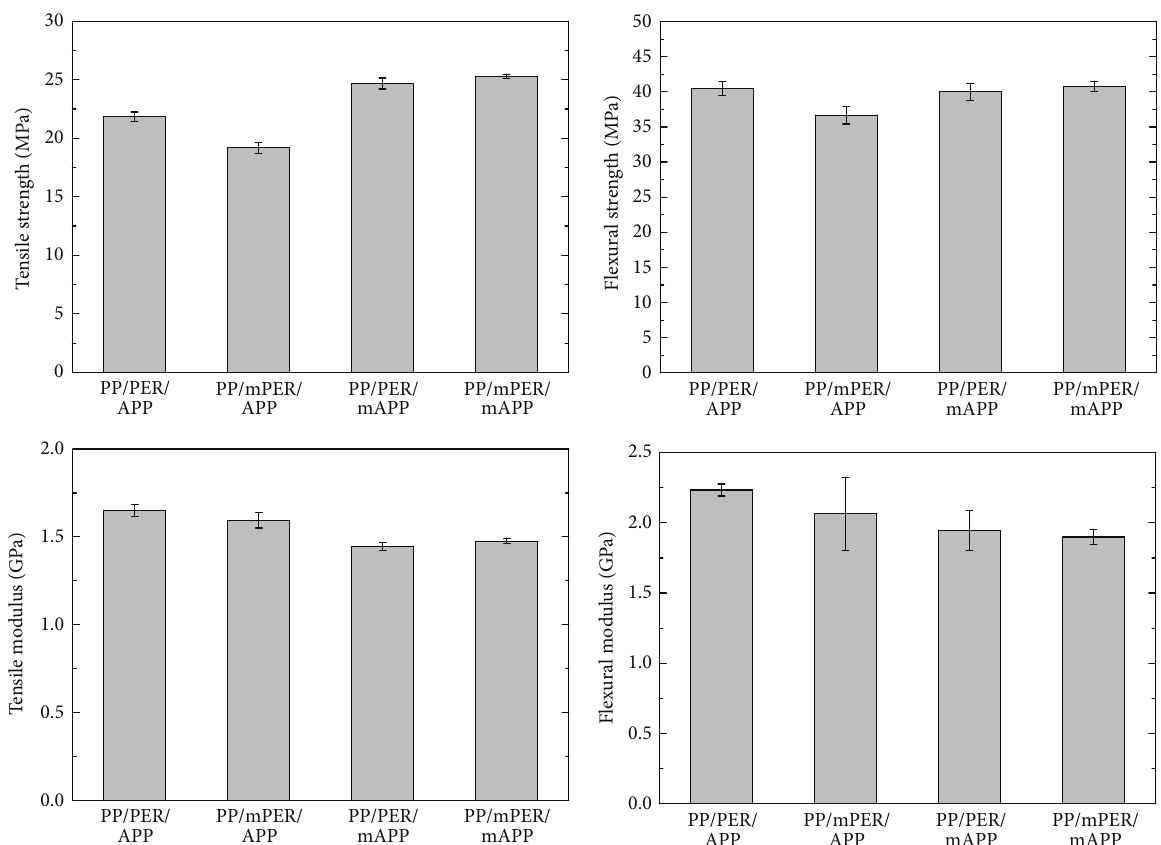
Figure 6: Comparison of the tensile and flexural strength and modulus of the intumescent flame retarded PP compounds.